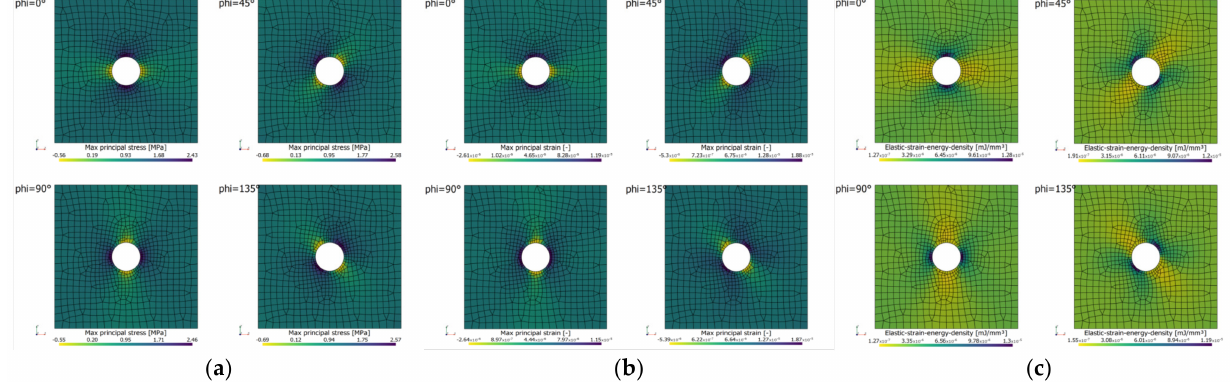
Figure 26. ESED evaluation of coarse-meshed circular hole-in-plate (mesh ‘circle_lin_R1mm_v1’) by tensor superposition: ( a ) Stress contour plots; ( b ) Strain contour plots; and ( c ) Elastic strain energy density contour plots for load angle of ϕ = 0, 45, 90, 135 ◦